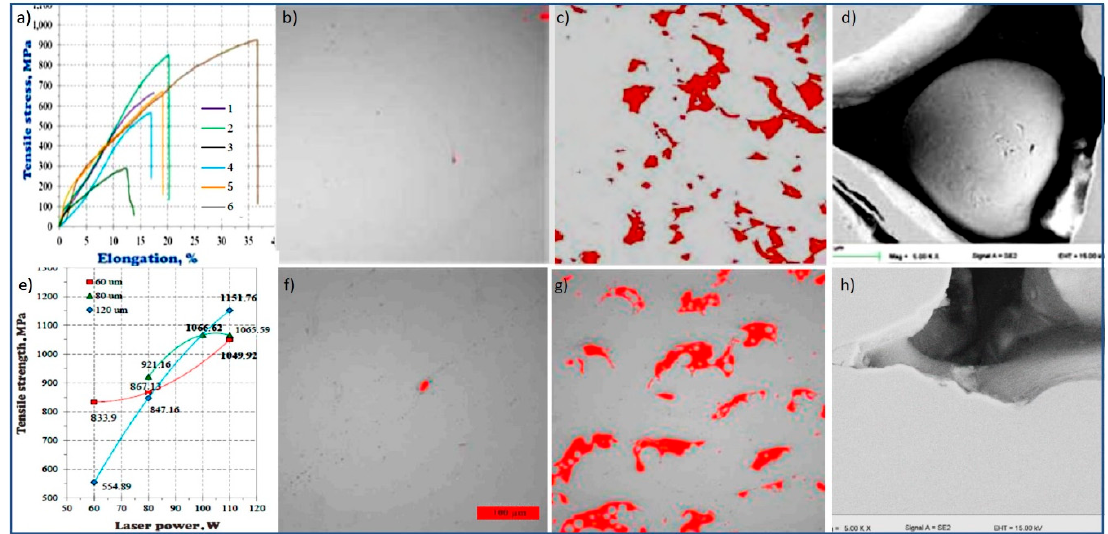
Figure 26. Influence of manufacturing conditions during selective laser sintering of powder on the tensile strength and structure of: ( a – d ) Co25Cr5Mo5WSi alloy; ( e – h ) Ti6Al4V alloy: ( a ) tensile strength (powder thickness 25 µm; laser power 105 W; laser spot diameter 10 µm (variant 4–80 µm), scan speed 630 mm/s; laser beam width variant 1,4,5—120 µm, variant 2,3—80 µm, variant 6—100 µm, allowance, variant 1,2,4.5—0, variant 3.6—10%; variant 6—incorrect flow of protective gas); ( b ) porosity 0.08%—option 3; ( c , d ) porosity 9.87%—variant 1; ( e ) tensile strength; ( f – h ) porosity ( f ) correctly sintered alloy 0.06%; ( g , h ) under extremely inadequate conditions 10.53%; ( d , h ) pores resulting from incompleteness of liquid phase sintering; ( b , c , f , g ) LM; ( d , h ) SEM.